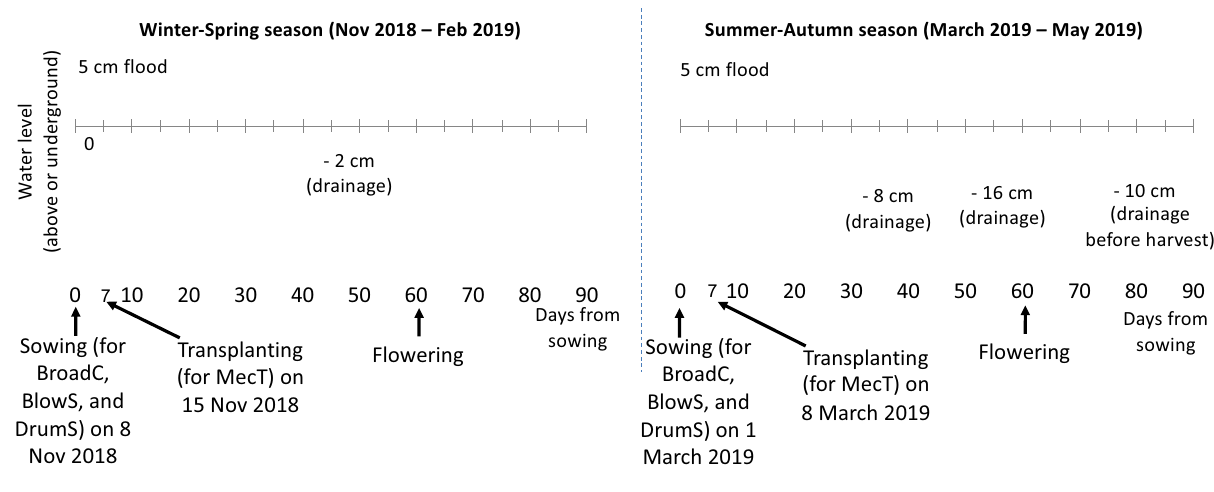
Figure 2. Water level (above- or under-ground) during the SA and WS cropping